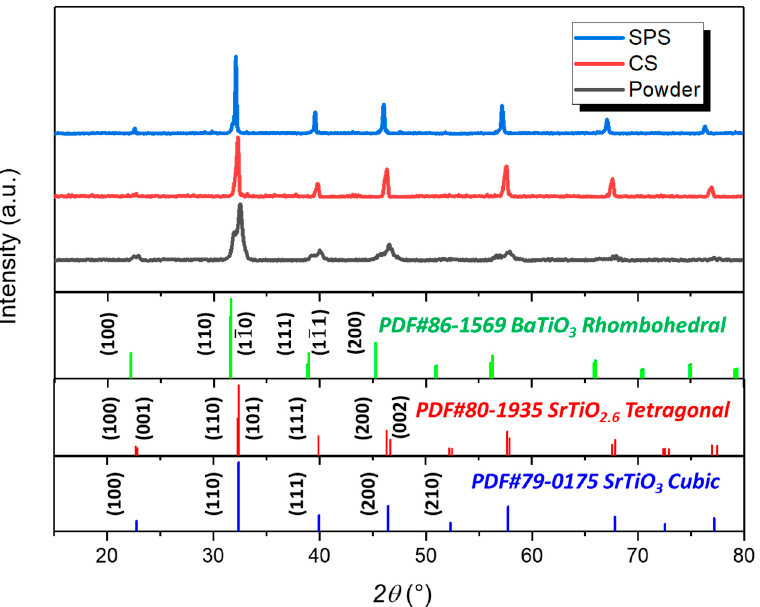
Figure 1. XRD patterns of the BNSBCT ceramic in different states: calcinated powder, conventionally sintered, and spark plasma